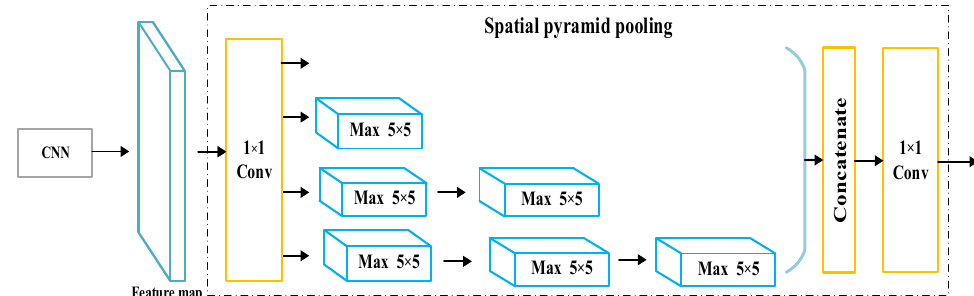
Figure 7. Spatial pyramid pooling structure.